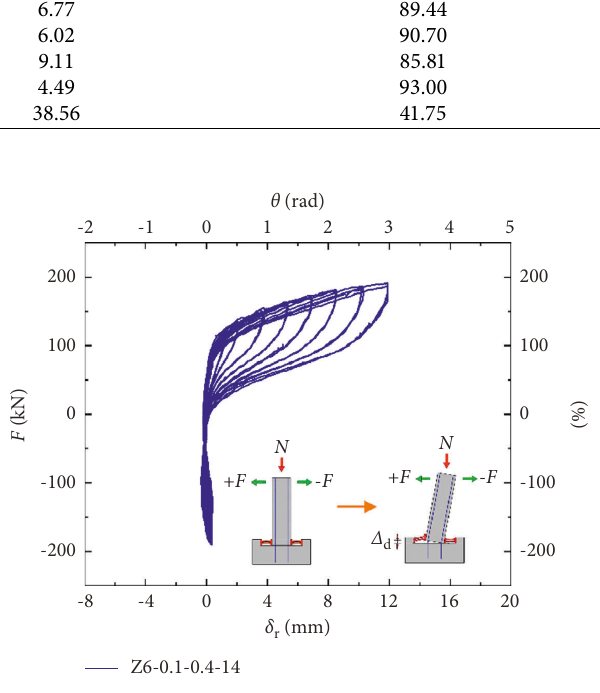
Figure 22: The relationship between F and δ . r